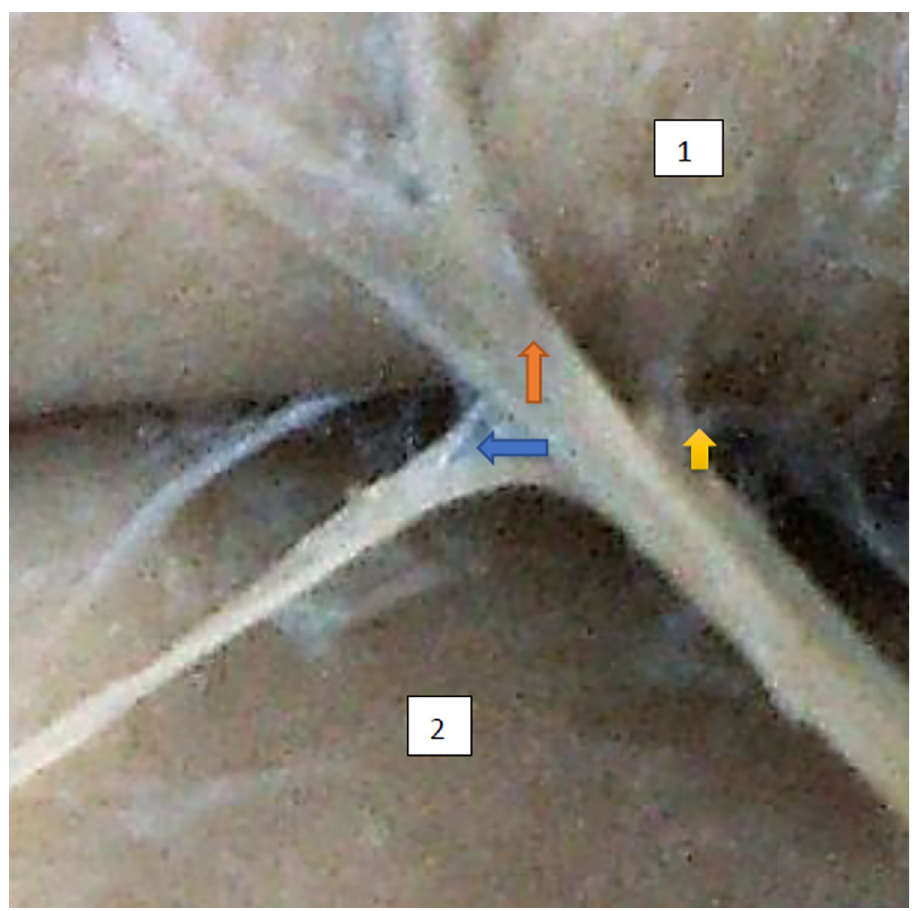
Fig 3. Superior gluteal nerve, tree type, morphological age 184–27–VII, V–tub 220,V–pl 331. 124–18–V, V–tub 130,V–pl 190, mass 627, male sex, magnification 40x, –1– gluteus medius muscle, 2– gluteus minimus muscle, red arrow–branch to gluteus medius muscle, yellow arrow–branch to gluteus minimus muscle, blue arrow–branch to tensor fasiae latae